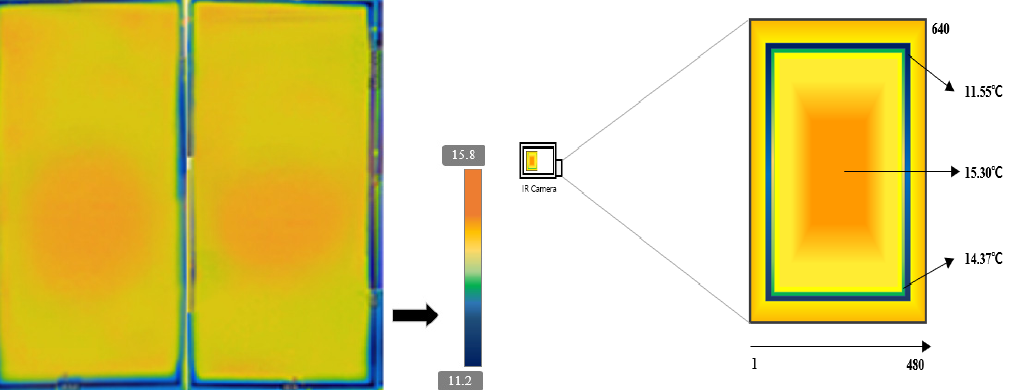
Figure 7. Window surface temperature using an IR camera.